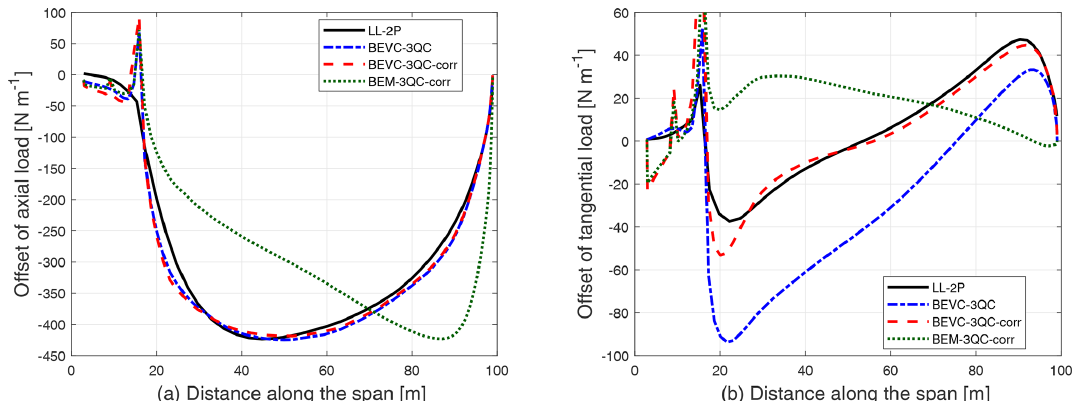
Figure 15. Comparison of the difference in axial load (a) and tangential load (b) of the straight blade with 15 ◦ of upwind coning with respect to the straight blade without coning calculated from LL-2P, BEVC with and without the correction (BEVC-3QC-corr, BEVC-3QC), and the BEM method with the correction (BEM-3QC-corr).